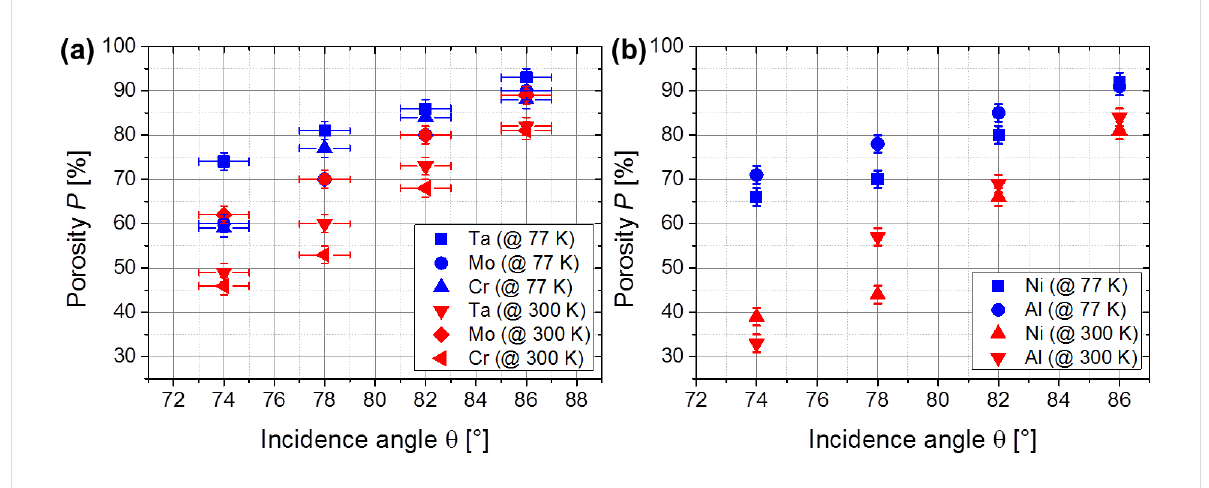
Figure 7: Porosity of (a) Ta, Mo and Cr and (b) Ni and Al thin films versus incidence angle.